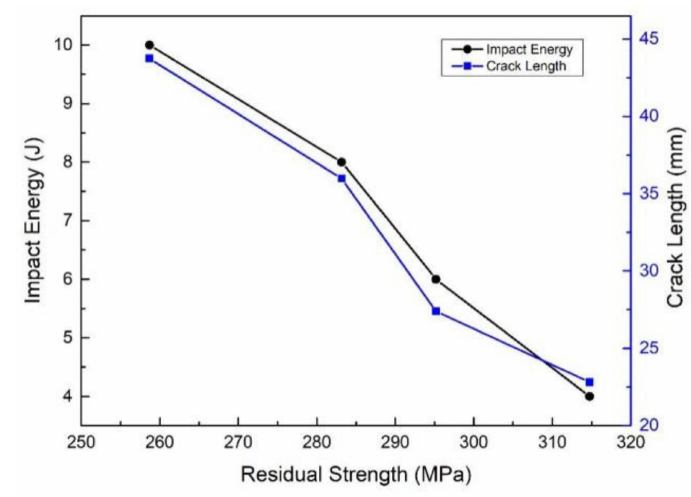
Figure 13. Residual strength versus impact level and crack length.